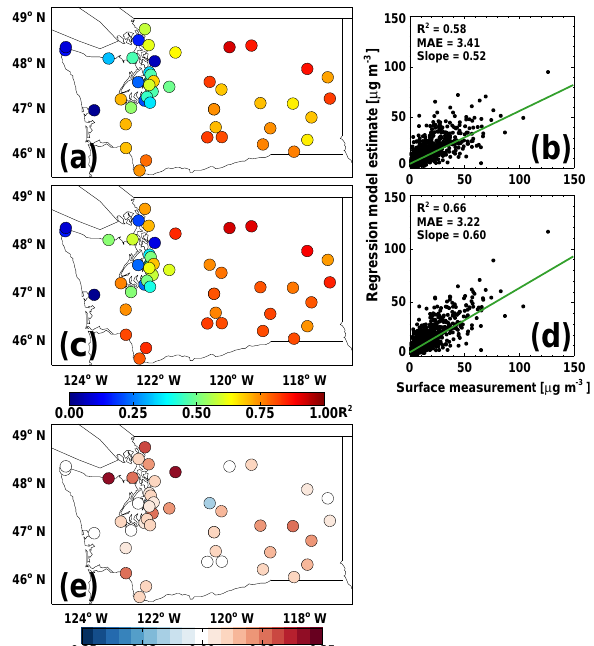
Figure 7. R 2 values at each measurement site for surface PM 2 . 5 and regression model estimate (a) using MODIS AOD and WRF-Chem PM 2 . 5 and (c) using MODIS AOD, WRF-Chem PM 2 . 5 , and the per- cent of Facebook posters for 5 June to 30 September 2015. The difference in R 2 (e) between the two regression models (with Face- book posters and without Facebook posters). Also shown are scat- terplots for all daily measured PM 2 . 5 and corresponding regression model estimates in the domain (b) using MODIS AOD and WRF- Chem PM 2 . 5 and (d) using MODIS AOD, WRF-Chem PM 2 . 5 , and Facebook